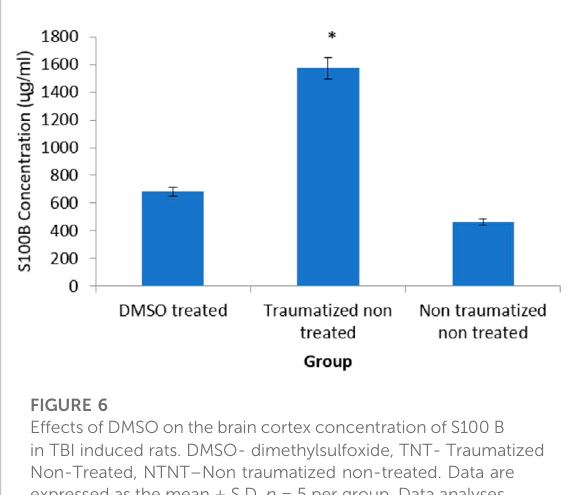
FIGURE 5 EffectsofDMSOonanxiety-likebehaviorofratsinducedwith TBI; DMSO- dimethylsulfoxide, TNT- Traumatized Non-Treated, NTNT – Non traumatized Non treated. Data are expressed as the mean ± S.D. n = 7 per group. Data analyses were conducted using a one-way analysis of variance (ANOVA). Post hoc analyses were performed using Tukey ’ s multiple comparison tests when appropriate. * p < 0.05 compared to the traumatized non-treated and non-traumatized non treated groups.